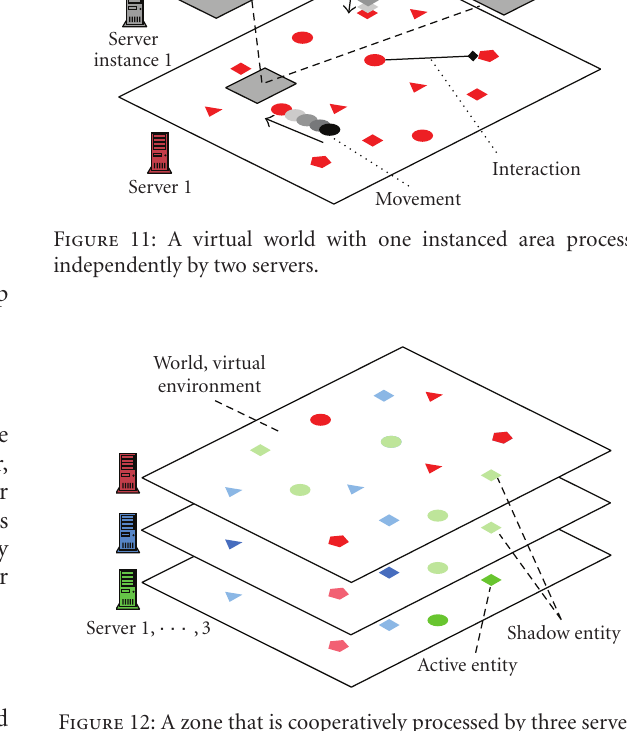
Figure 12: A zone that is cooperatively processed by three